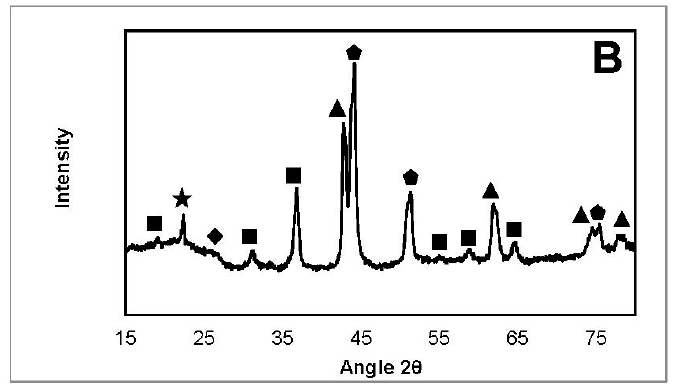
Figure 13. XRD spectra of Ni-UGSO after bio-oil MemU SR at 800 ◦ C: ( A ) WHSV = 1.7 g/g cat /h; and ( B ) WHSV = 6.6 g/g cat /h.